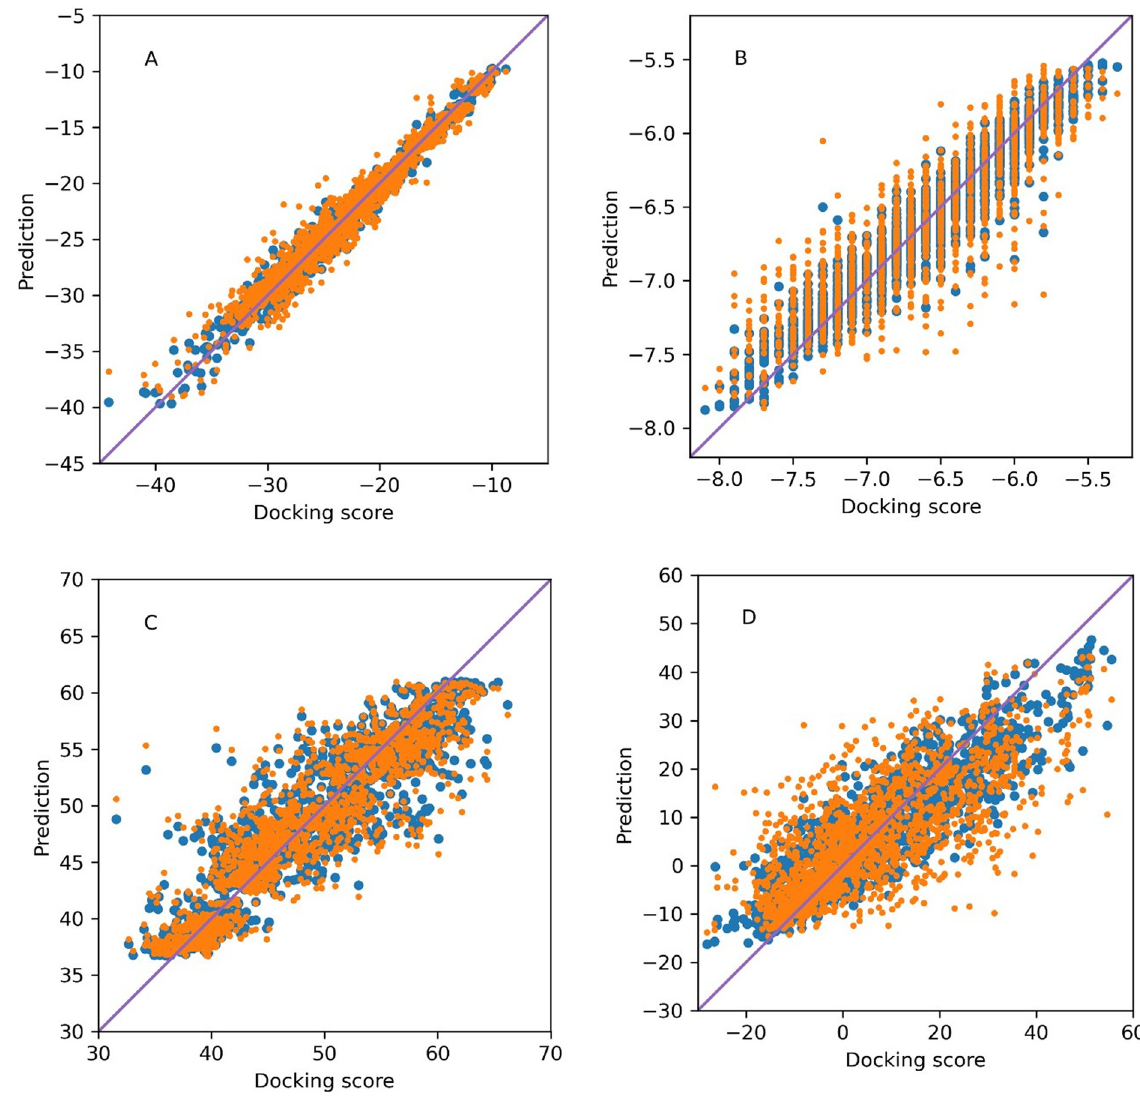
Fig 1. Predicted vs original docking scores obtained by Random Forests for scores computed by FlexX (A), Vina (B), ChemPLP (C), and Hyde (D). Blue points—learning stage, orange points–leave one out cross-validation stage.